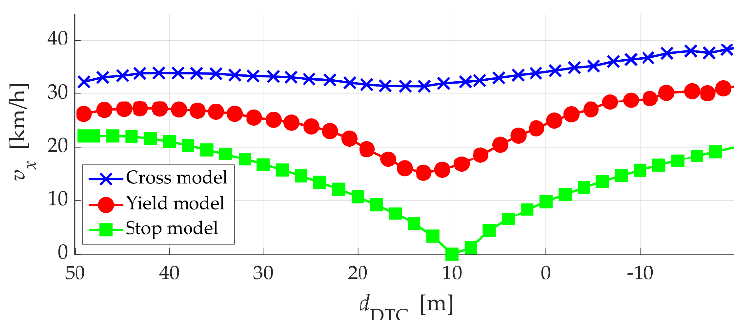
Figure 6. Velocity profile of behavior models for target vehicle intention inference.